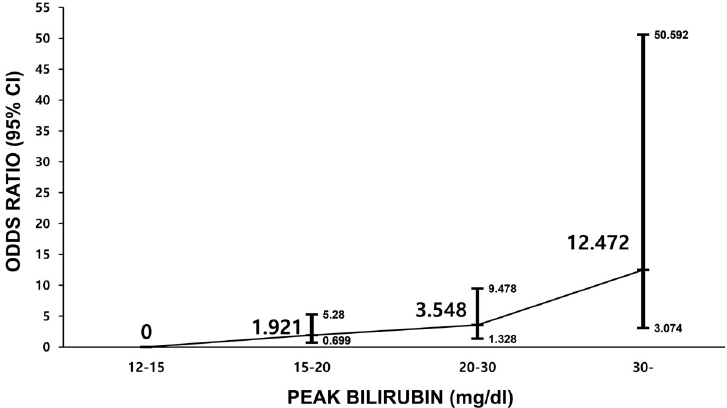
Fig 1. Relative mortality risk according to the peak bilirubin grade (multivariable logistic analysis). Model 2, multivariable logistic analysis with sex, age, body mass index (BMI), medical history (alcohol drinking, smoking, diabetes mellitus, hypertension, dyslipidemia, chronic liver disease, obstructive jaundice, cancer, hepatic encephalopathy, disseminated intravascular coagulation (DIC), acute on chronic liver failure (ACLF), ischemic heart disease, stroke, hypoxic hepatitis, sepsis, and shock), cardio-pulmonary resuscitation (CPR), extracorporeal membrane oxygenation (ECMO), liver surgery, ursodeoxycholic acid (UDCA), the initial Sequential Organ Failure Assessment (SOFA) score, number of dysfunctional organs, laboratory results, and type of hyperbilirubinemia. Abbreviation: OR, odds ratio; CI, confidence